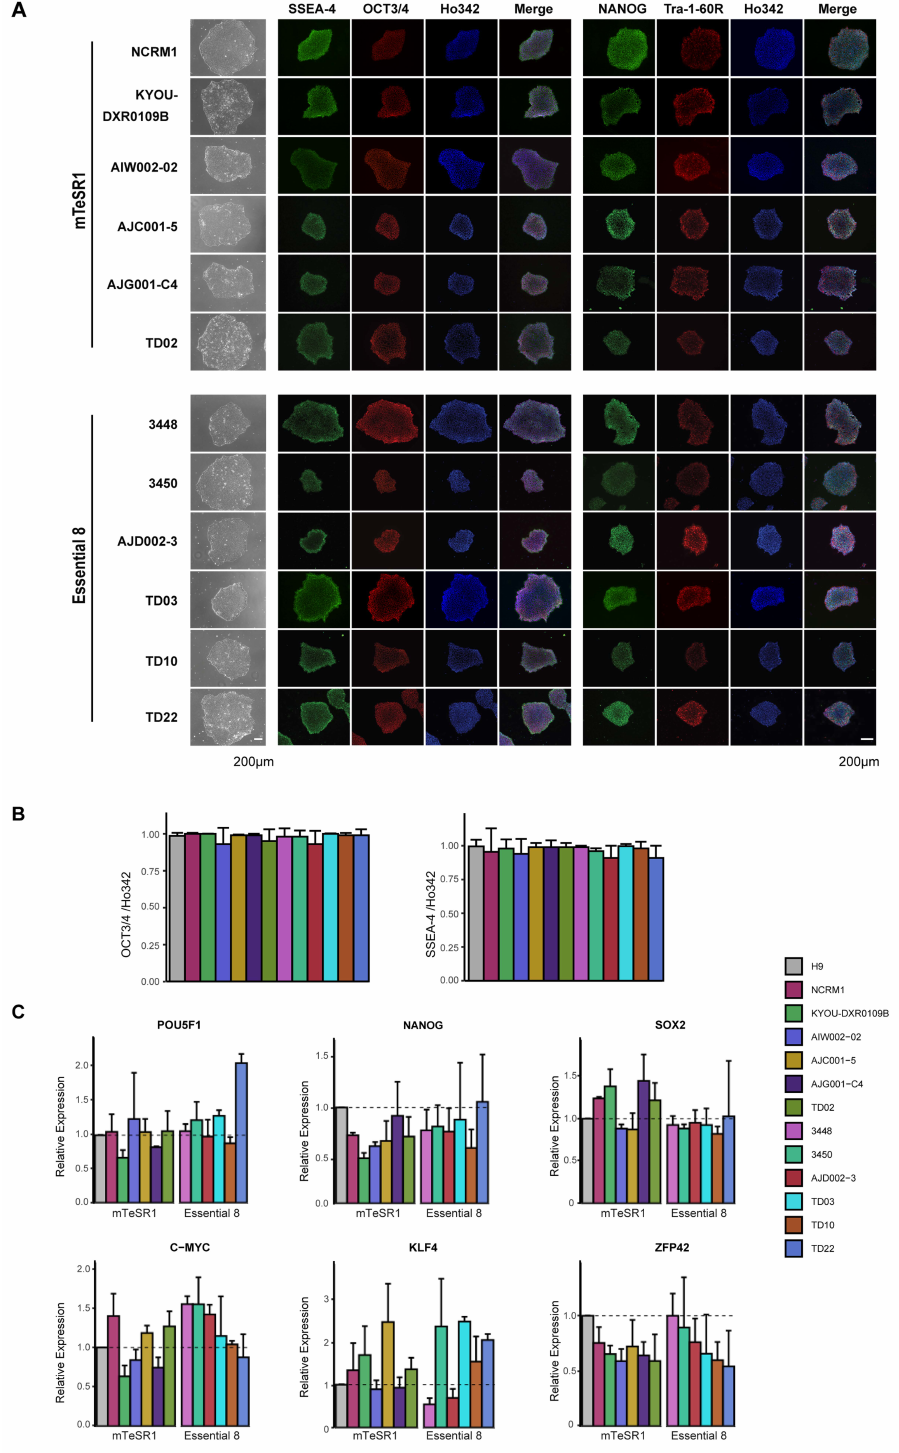
Figure 3. Expression of pluripotency markers in hiPSCs. ( A ) Phase contrast images and ICC for pluripotency markers SSEA-4, OCT3/4, NANOG, and Tra-1-60, with Ho342 nucleic acid counterstain. ( B ) Quantification of OCT3/4-positive cells or SSEA-4-positive cells shown in ( A ). ( C ) qPCR for mRNA expression of pluripotency genes POU5F1, NANOG, c-MYC, KLF4, SOX2, and ZFP42 in hiPSCs compared to H9 ESCs. mRNA expression in H9 was set as 1.0. The mean and SD are from technical triplicates from three independent